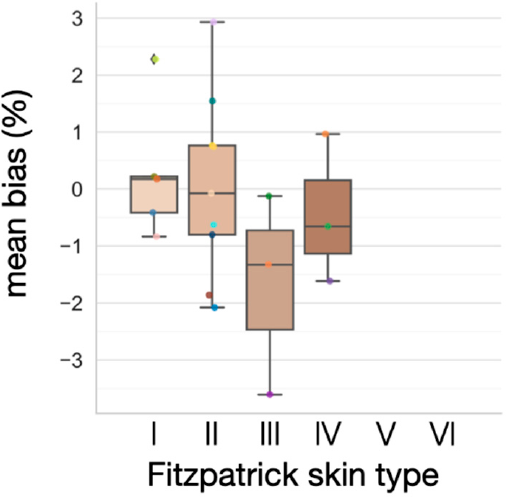
Figure 9. Mean bias across varying Fitzpatrick skin types. The differences between Fitzpatrick skin types are not statistically significant ( p > 0.05). One-way analysis of variance (ANOVA) was used for statistical analysis.